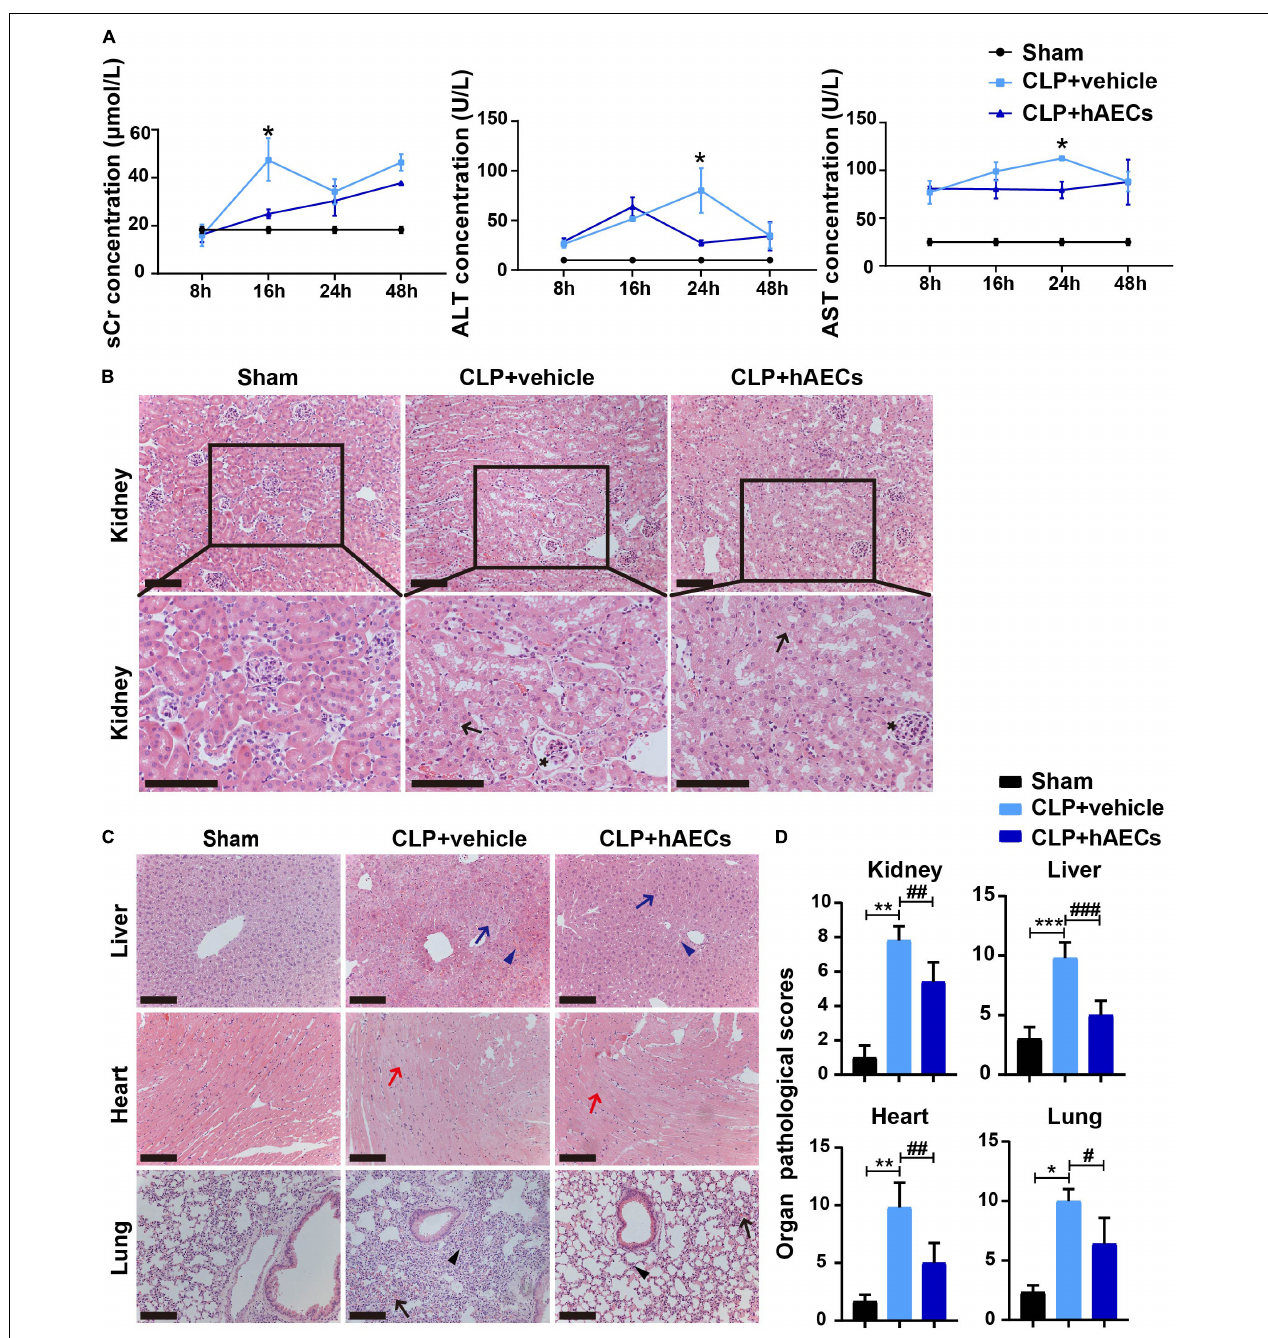
FIGURE 2 | hAECs ameliorated multiple organ damage of CLP mice. (A) Serum creatinine, alanine aminotransferase, and aspartate aminotransferase concentrations at different times in mice with CLP operation followed by vehicle ( n = 5) or hAECs ( n = 5) injection. * P < 0.05 vs. the CLP + vehicle group. (B) Renal pathology of septic mice at 16 h after CLP or CLP with hAECs treatment. Representative micrographs from each group are shown. The arrows indicate tubular epithelial vacuolization and the loss of brush border and the asterisks indicate Bowman’s capsule expansion (H&E staining; scale bar = 50 µ m). The lesions in the kidney were alleviated by the hAECs treatment. (C) Pathology of liver, heart, and lung of septic mice at 16 h after CLP or CLP with hAECs treatment. Representative micrographs from each group are shown. The blue arrows indicate vacuolization of hepatocyte cytoplasm and the blue arrowheads indicate sinusoidal congestion of liver tissues. The red arrows indicate edema and vacuolization of myocardial cells of heart tissues. The black arrows indicate alveolar congestion and hemorrhage. The black arrowheads indicate infiltration or aggregation of neutrophils in airspaces of lung tissues (H&E staining; scale bar = 50 µ m). The lesions in the liver, heart, and lung were alleviated by the hAECs treatment. (D) Organ pathological scores representing the degree of lesion damage at 16 h after CLP. * P < 0.05, ** P < 0.01, *** P < 0.001 vs. the sham group; # P < 0.05, ## P < 0.01, ### P < 0.001 vs. the CLP + vehicle group.